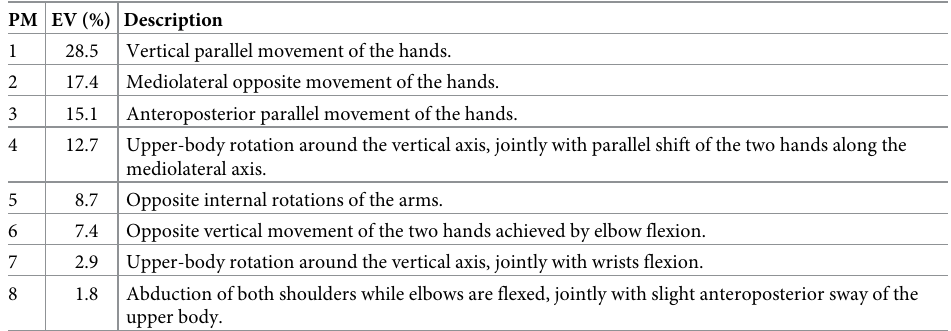
Table 1. Characterization of the first eight common PMs. EV is the Explained Variance in original